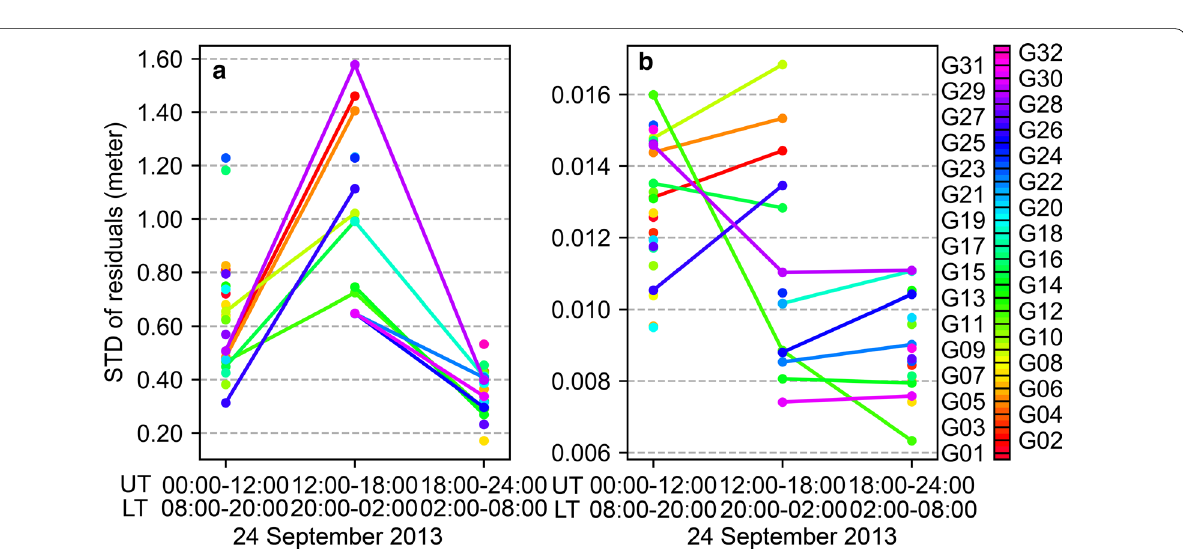
Fig. 17 STD of residuals on ionosphere-free pseudorange ( a ) and carrier phase ( b ) measurements from three periods (1) 00:00–12:00 UT; (2) 12:00–18:00 UT; (3) 18:00–24:00 UT for the baseline HKPC–HKOH on 24 September 2013. The isolated points without linkage with other points mean that the satellites are just visible in one of the three